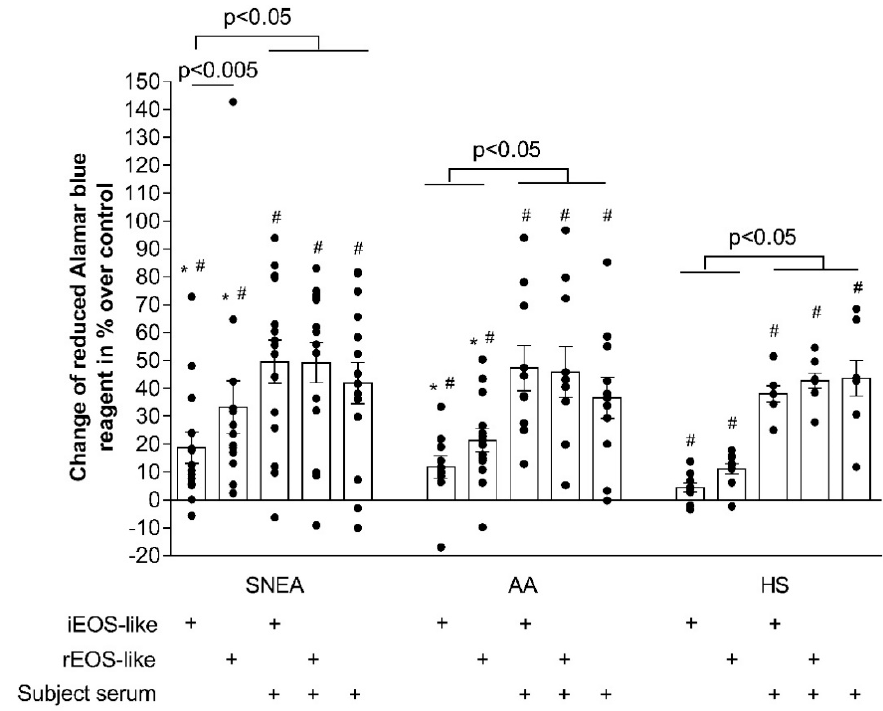
Figure 5. ASM co-culture with either rEOS-like or iEOS-like cells and the effect on ASM cell prolif- eration. SNEA, severe non-allergic eosinophilic asthma; AA, allergic asthma; HS, healthy subjects. Results from independent experiments of SNEA, n = 16, AA n = 13, HS n = 12. # p < 0.05 compared with control ASM cells not co-cultured with eosinophils; * p < 0.05 compared with the HS group. The final concentration of the added blood serum was 2% v/v . Statistical analysis: between investigated groups, Mann–Whitney two-sided U-test; within one study group, comparing each point of the subject individually, Wilcoxon matched-pair, signed-rank, two-sided test.